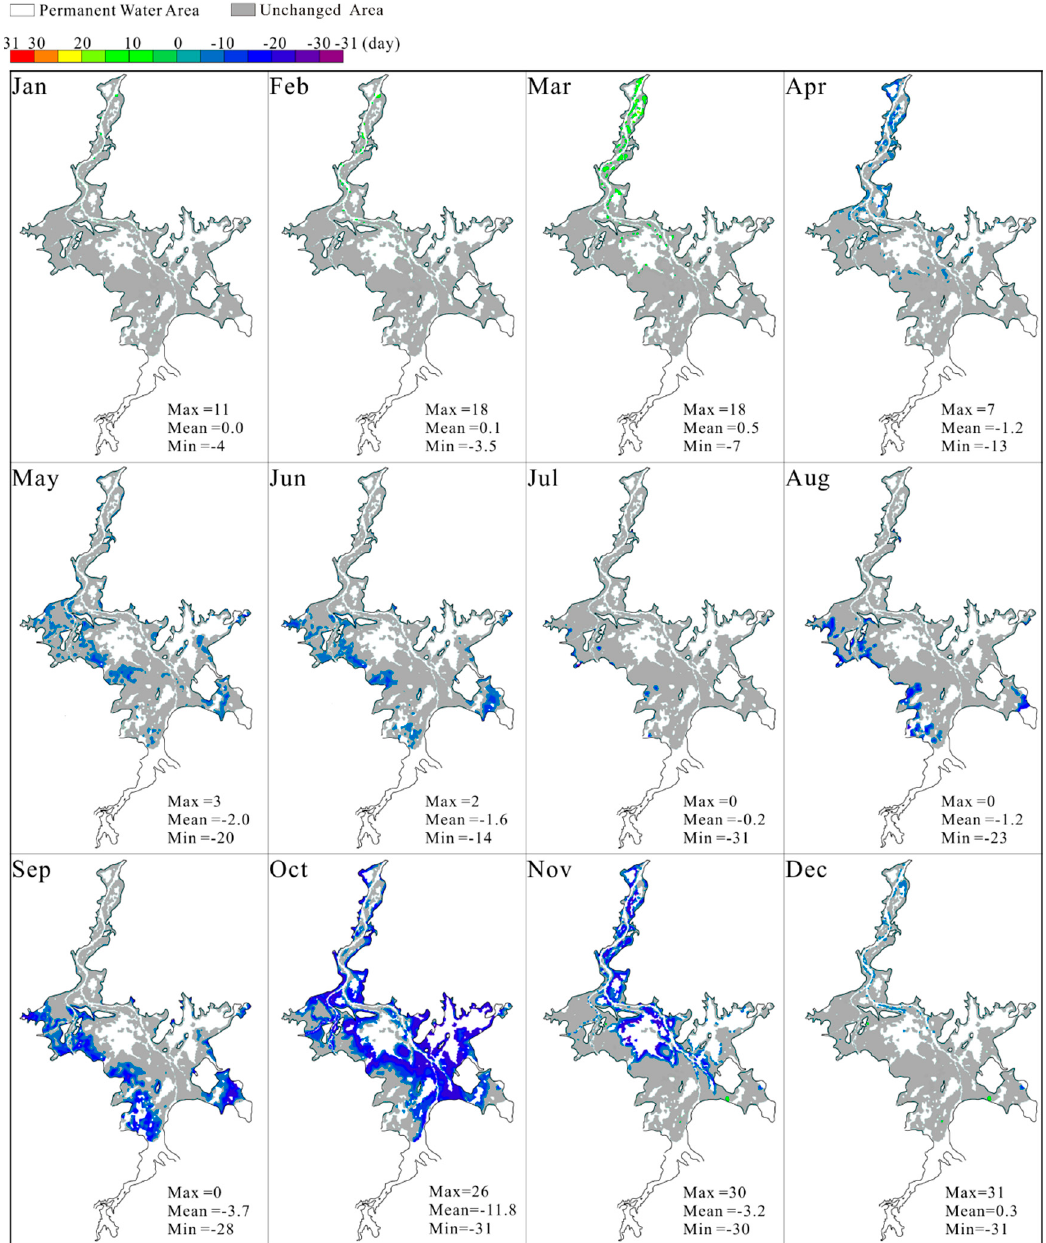
Figure 6. Spatial differences and varying degree of average inundated days in the Poyang Lake floodplains between S1 and S2 (S1–S2). The gray area means the unaffected floodplains.